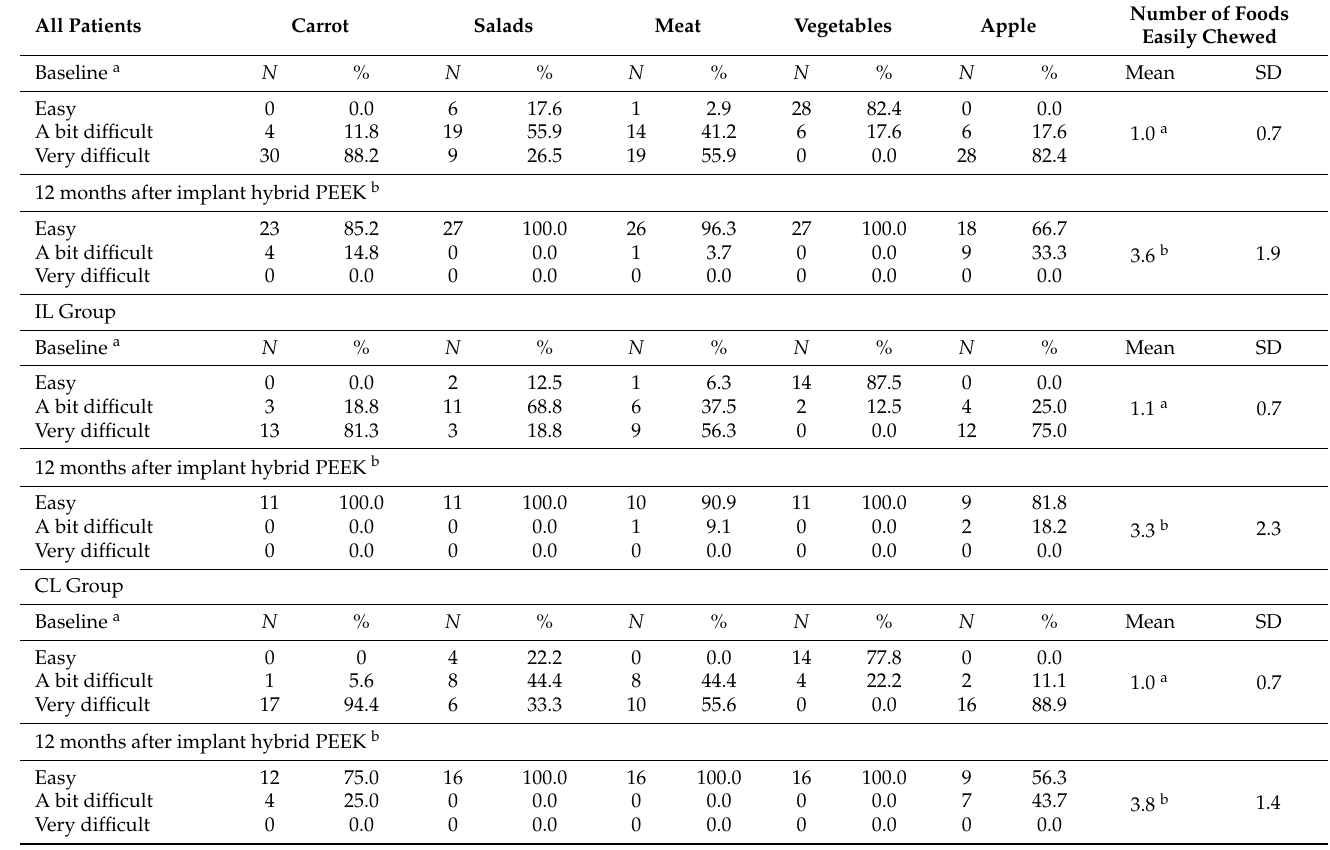
Table 6. Changes in the ability to chew according to Leake Index one year after PEEK-Hybrid dentures ( n = 34 at baseline; n = 27 at